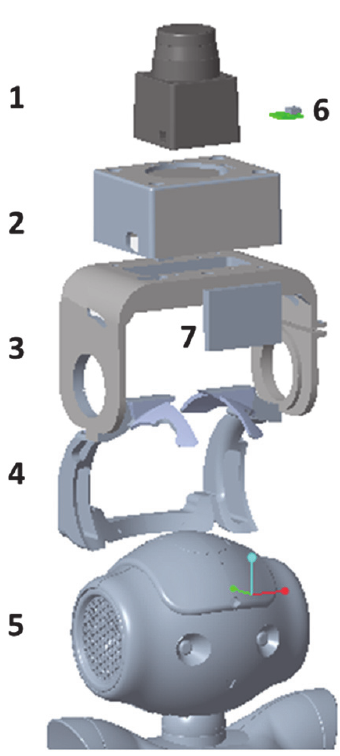
Figure 7. Helmet on the robot’s head: ( a ) front, ( b ) rear, and ( c ) side view.